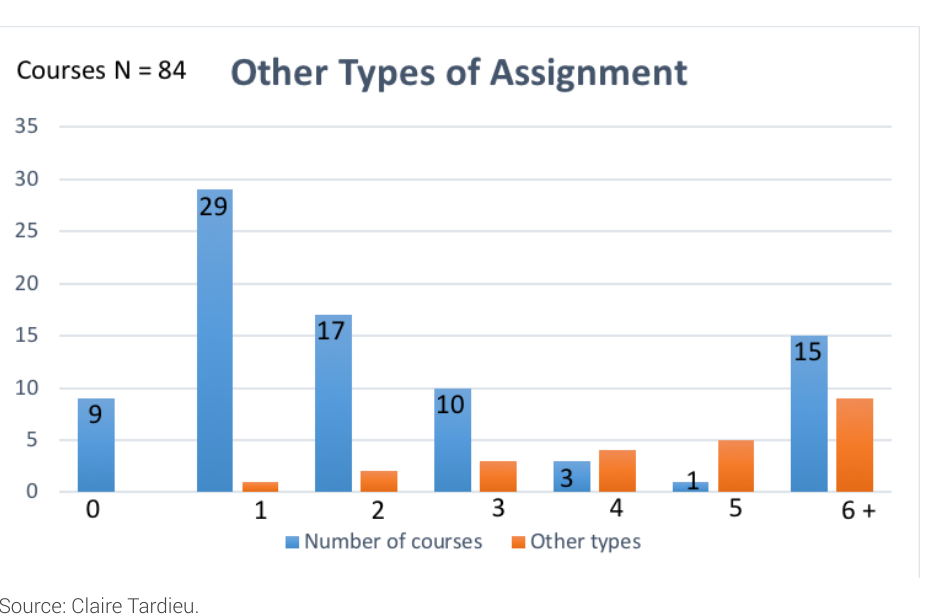
Figure 7: Other types of requirements